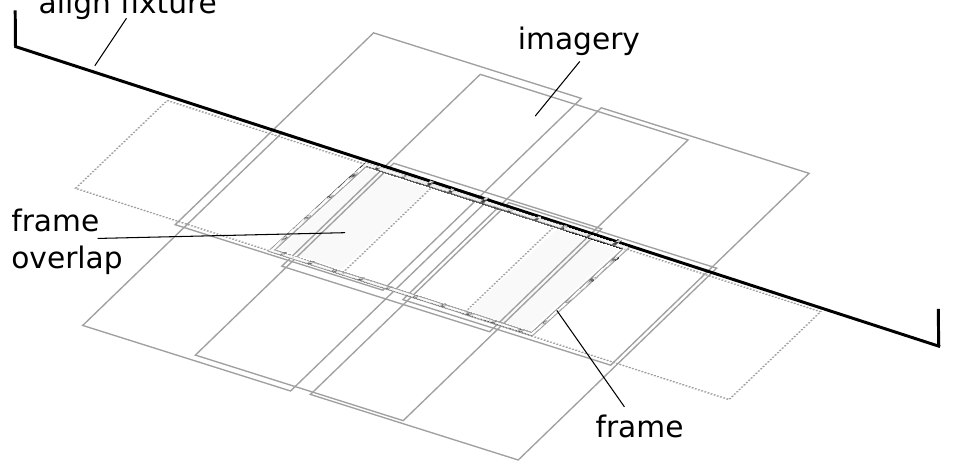
Figure 2. Roughness acquisition scheme and image arrangement for stereo coverage of the